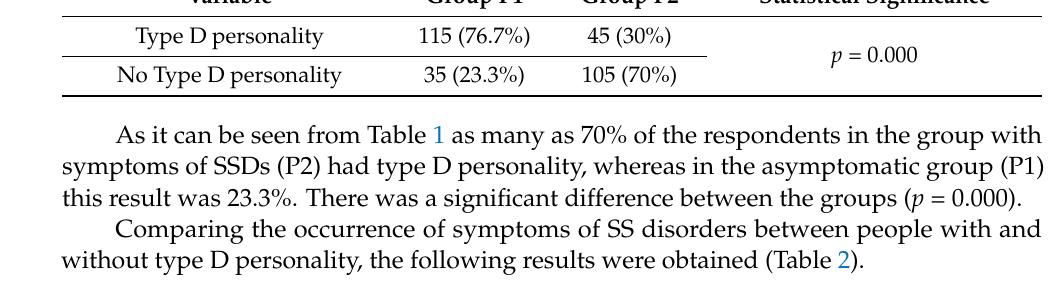
Table 2. The occurrence of symptoms of SS disorders in students with and without type D personality.